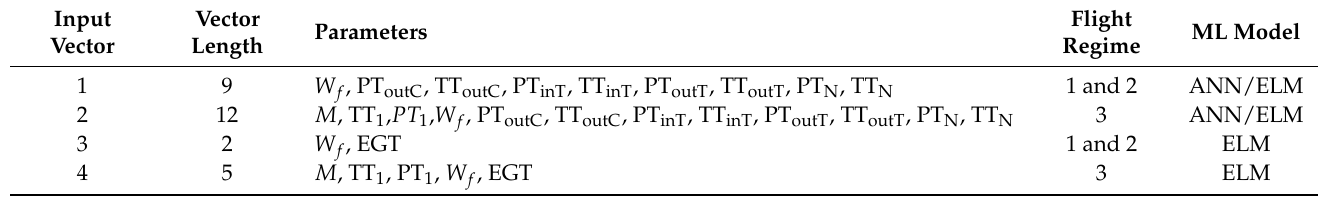
Table 4. Input vectors for ML